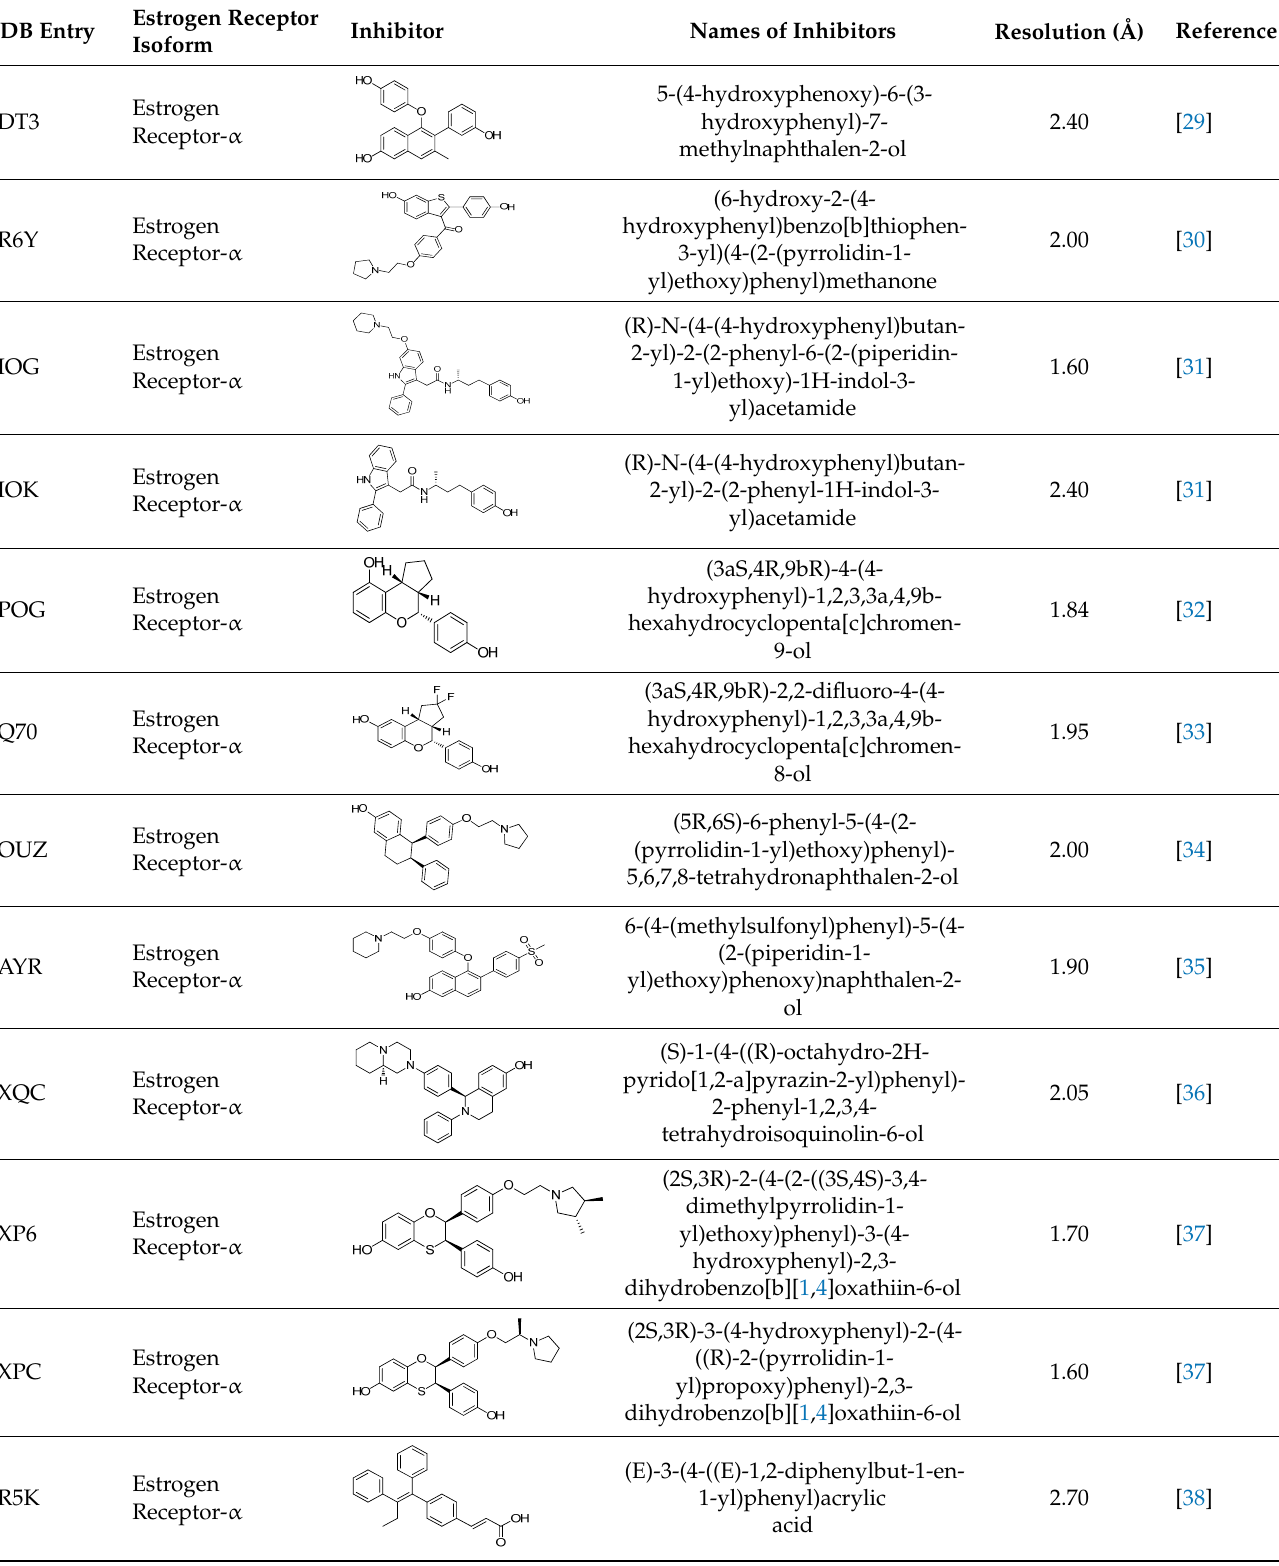
Table 1. Reported X-ray cocrystal structures of ER- α selective inhibitors.